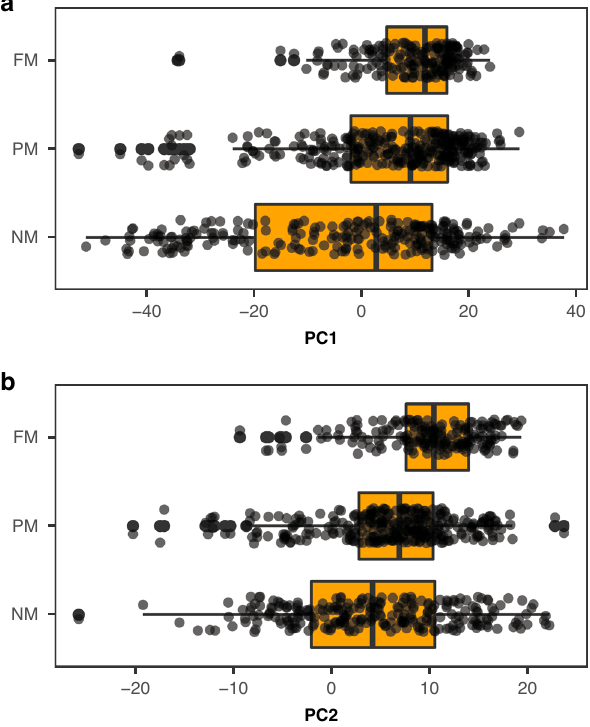
Fig. 4 Relationships between migratory strategies and life history traits. Migratory strategy and a PC1 scores (fast – slow continuum) and b PC2 scores (reproductive strategy) for fl ying species ( n = 777 species). Boxplots represent the median and the interquartile range (IQR) and the whiskers the 1.5*IQR. FM stands for fully migratory species, PM for partially migratory species and NM for non-migratory species.